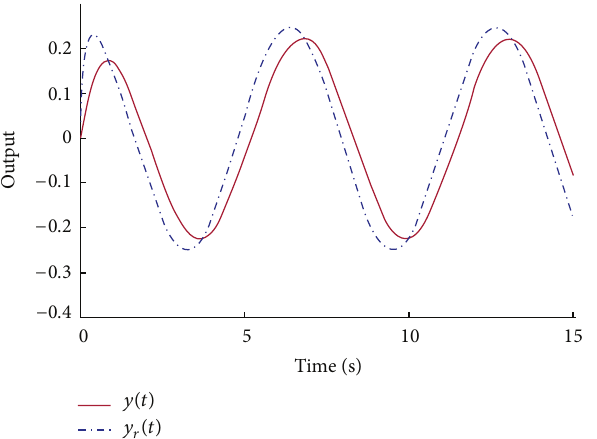
Figure 1: System output tracking trajectory with zero initial condi- tion.